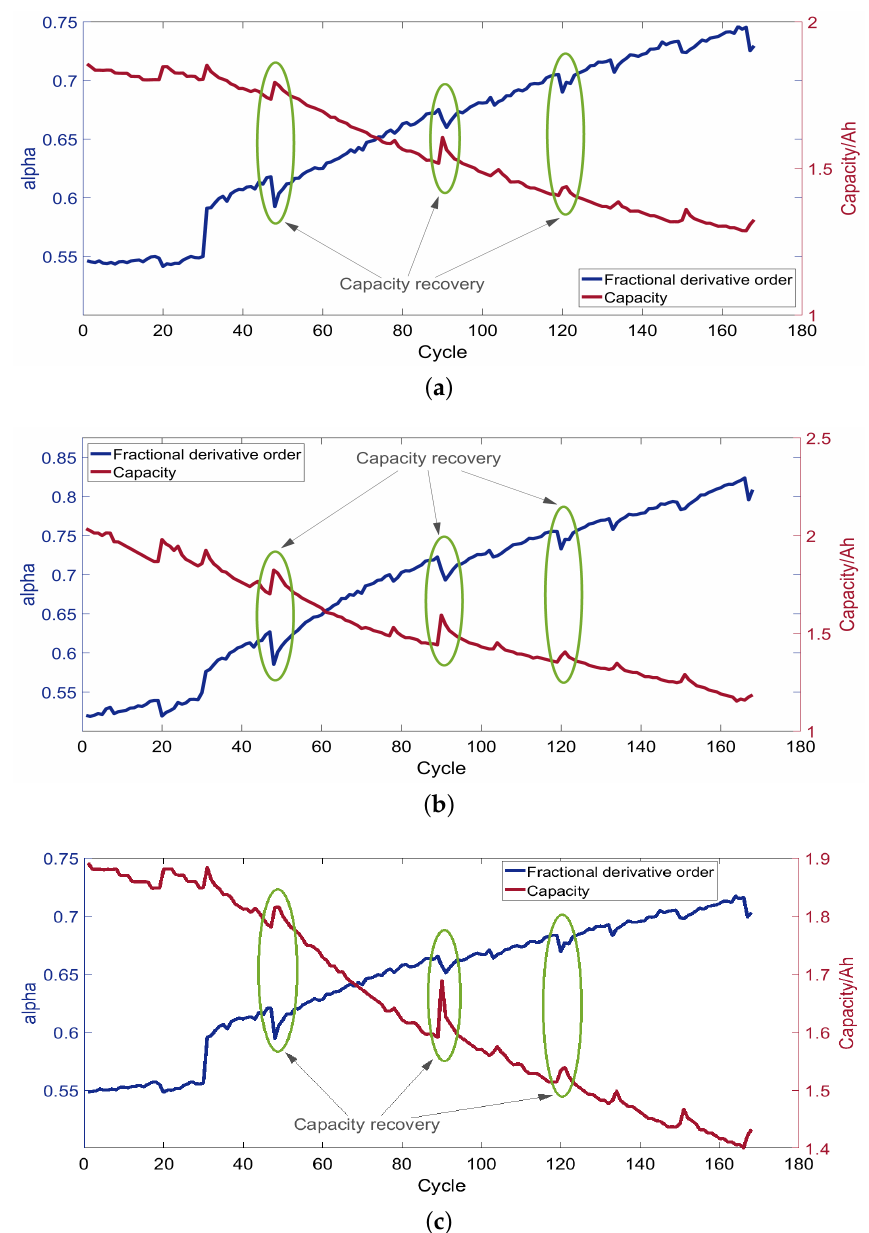
Figure 9. Identified FDO and the capacity degradation curve of the NASA18650 commercial lithium batteries: ( a ) battery 0005; ( b ) battery 0006; ( c ) battery